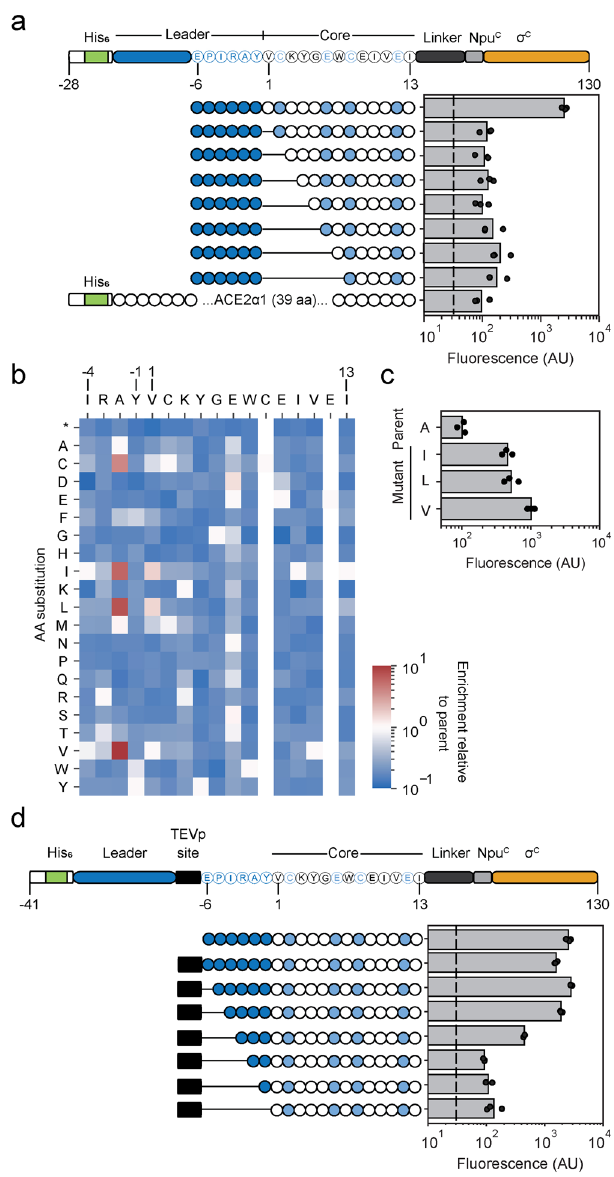
Fig. 3 Sequence-activity pro fi ling of Pap2c_1 yields better binders in vivo. a Schematic of Pap2c_1 peptide fusion used for in vivo measurements. Leader and core amino acids considered for pro fi ling are displayed and predicted modi fi ed core residues highlighted in light blue. A fusion protein of the 39 amino acid ACE2 α 1 peptide to the C-terminal NpuC- σ C was included as an off-target control. Dashed lines indicate the fl uorescence output of the circuit driven by the RBD:PMI interaction measured in Fig. 1d. 3OC6-AHL (1 µ M) was used for inductions and three replicates performed on different days are shown. b Heat map of variant enrichment from selection and NGS. Amino acid substitutions enriched relative to the parent sequence are colored red. c Fluorescence output of consensus variant strains constructed based on data from (b). Individually constructed variants at position -3 (A, I, L, V) were evaluated for fl uorescence output of the circuit. 3OC6-AHL (0 µ M) was used for inductions and three replicates performed on different days are shown. d Schematic of the Pap2c_1 peptide fusion used for in vivo measurements and TEV protease site insertion analysis. Modi fi ed core residues are shown in light blue. Dashed lines indicate the fl uorescence output of the circuit driven by the RBD:PMI interaction measured in Fig. 1d. 3OC6-AHL (1 µ M) was used for inductions and three replicates performed on different days are